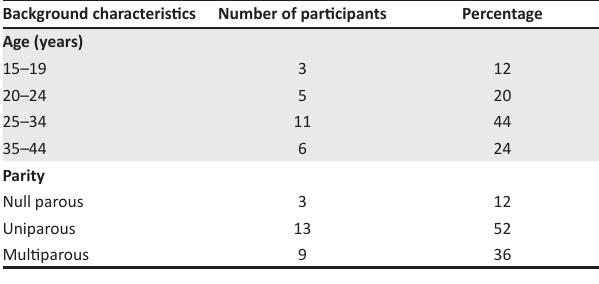
TABLE 4: Pregnant women ’ s education and